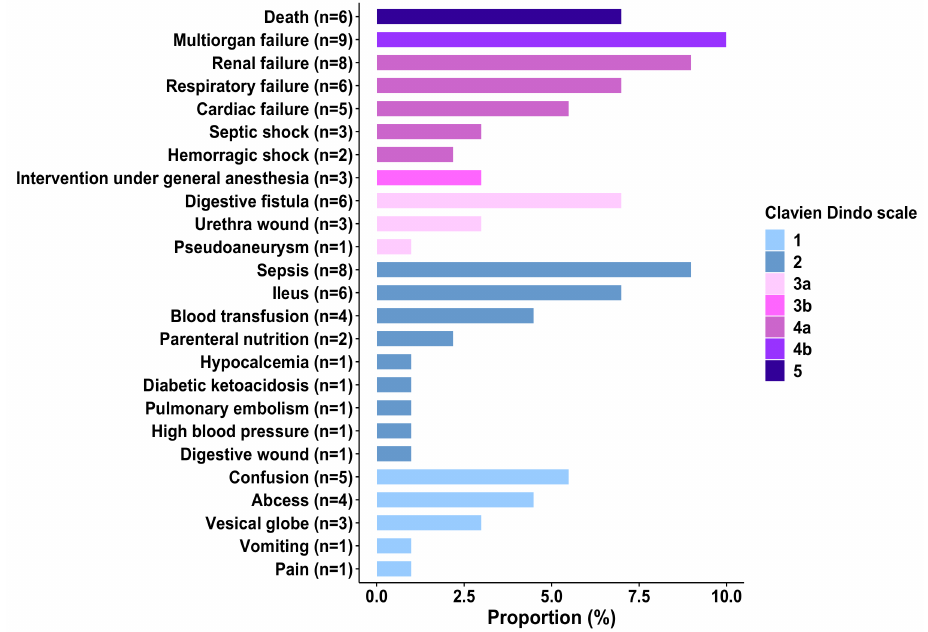
Figure 1. Bar plot of the 30-day post-operative complications among 136 older patients with major cancer